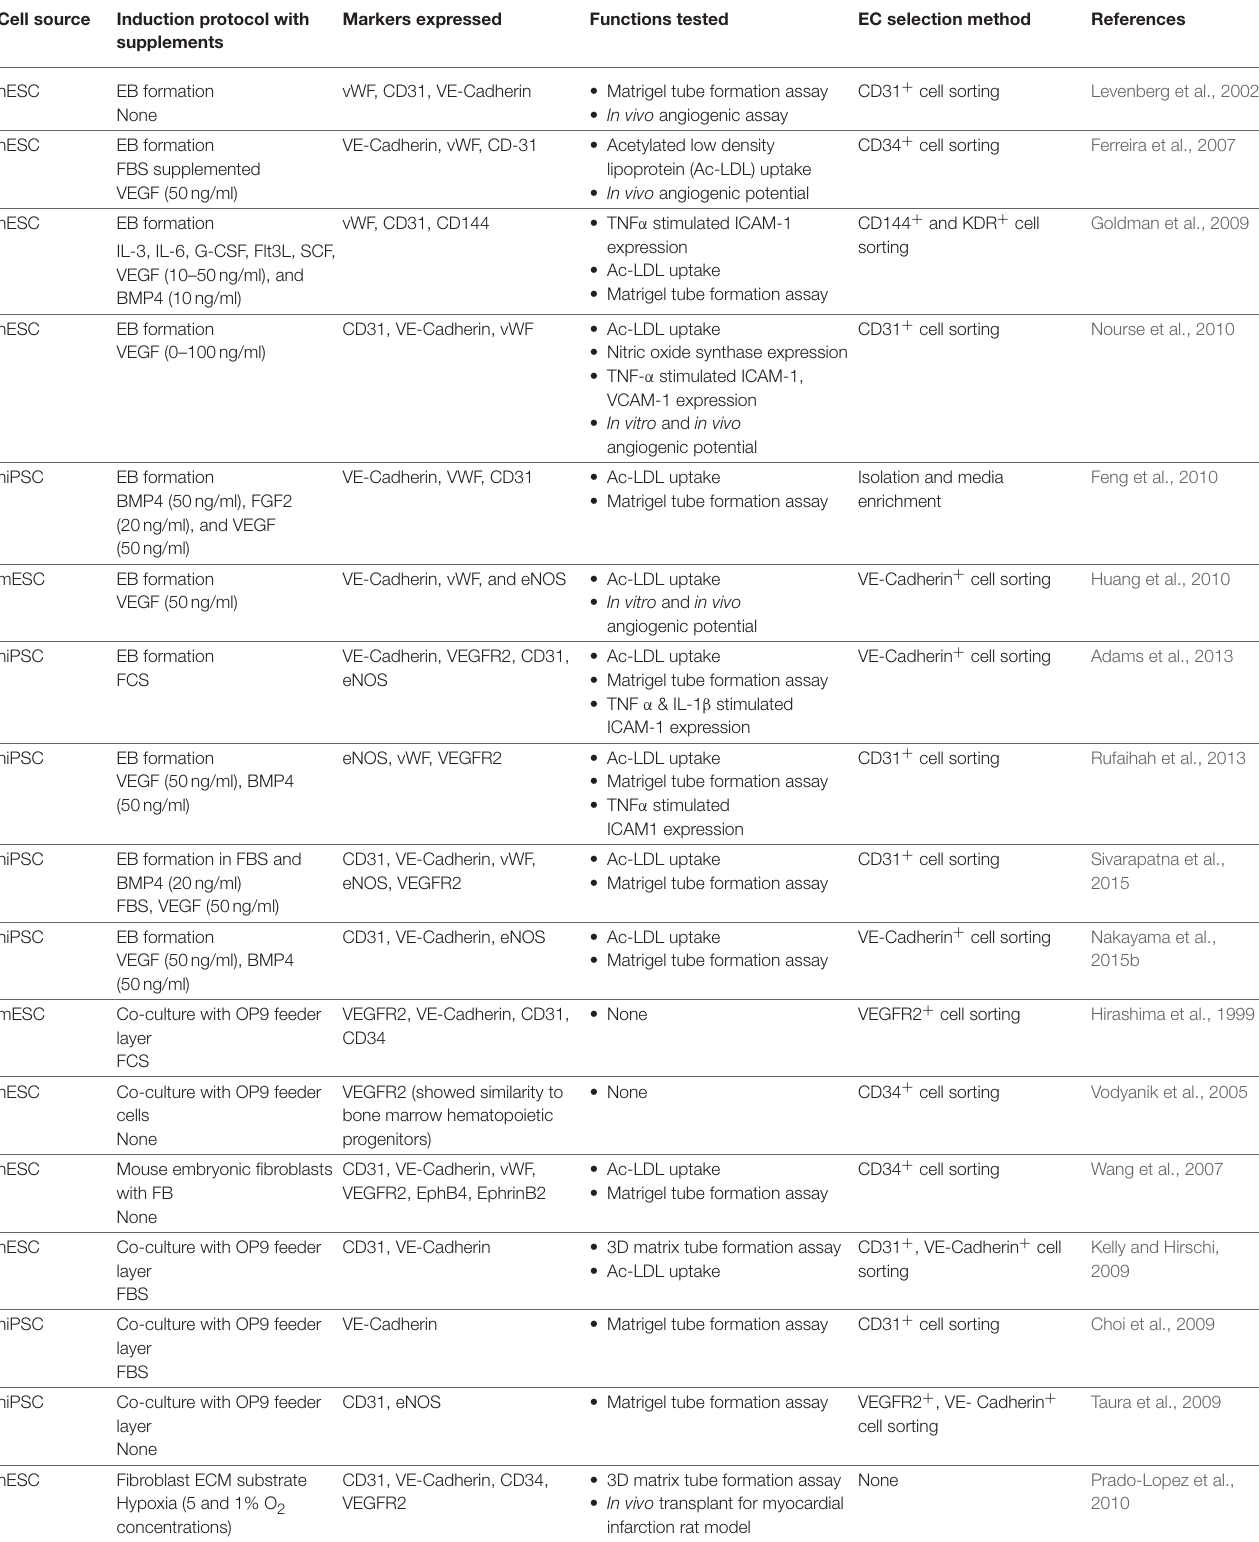
TABLE 1 | Derivation and characterization of ECs from PSCs classified by culture